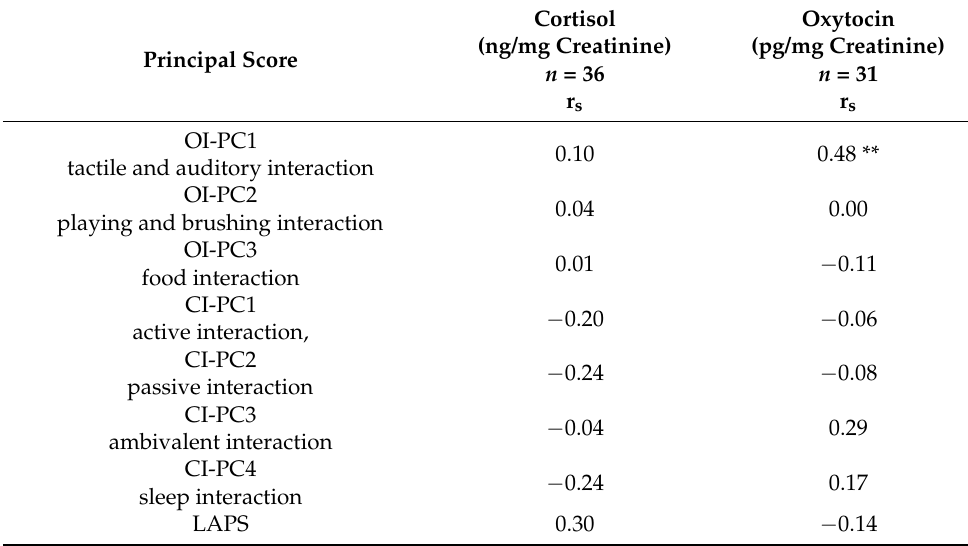
Table 6. Correlations between hormone levels and principal component